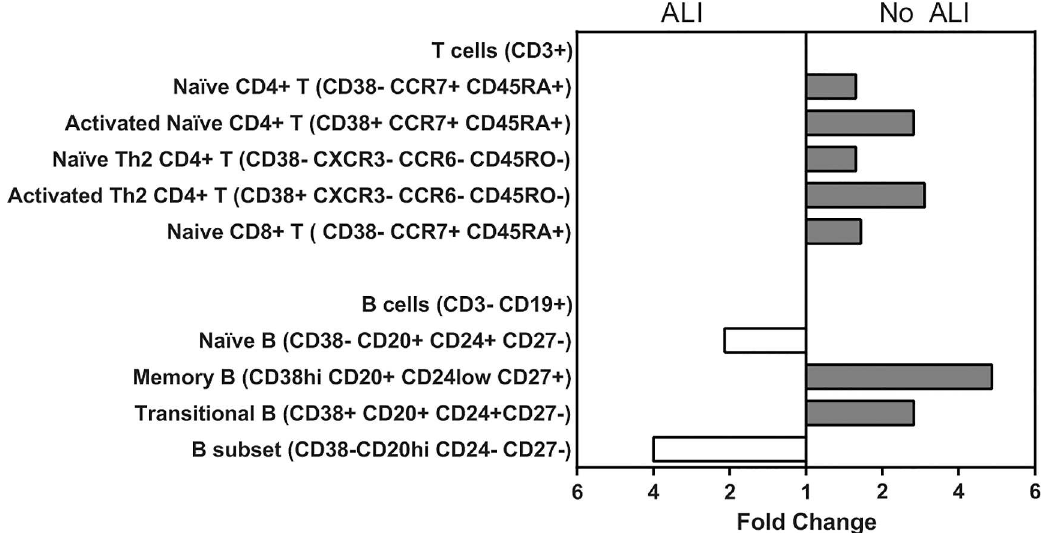
Fig 3. More robust T and B cell responses in patients lacking acute lung injury. PBMCs from patients with ALI (N = 4) and hospitalized patients lacking pulmonarycomplications (No ALI; N = 9) during acute leptospirosis. Cells were labeledwith fluorescent antibodies for immunophenotyping and analyzedby flow cytometry [36]. Live CD3 + cells or CD3 – /CD19 + cells were sampled and clustered by Citrus analysis, based on the expression of markers in each panel. Abundance of subsets was compared using SAM (FDR < 5%) between No ALI and ALI groups. Data shown represent fold changeratios of cell abundancefor the indicatedcell